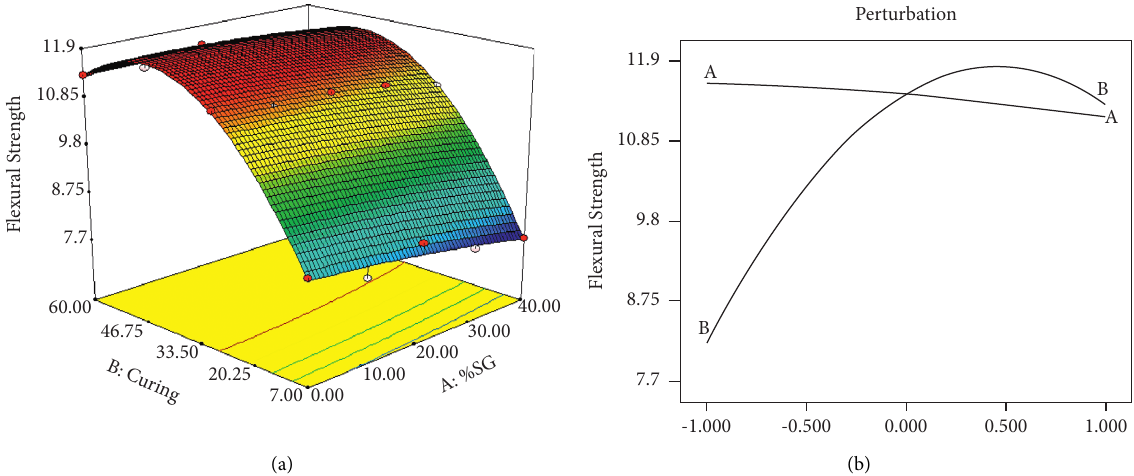
Figure 12: Response surface plots (a) and perturbation plots (b) indicating the relationship between spent garnet content and curing days with respect to flexural strength.